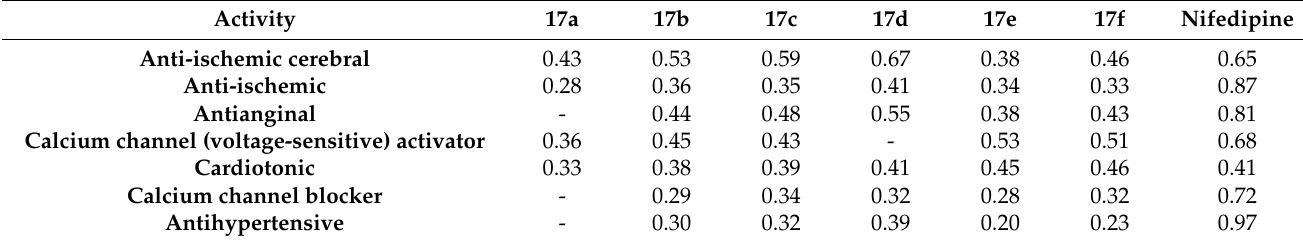
Table 3. The PASS predicted probability of the new pyrrole derivatives to be active (Pa) related to the calcium channel blockers.